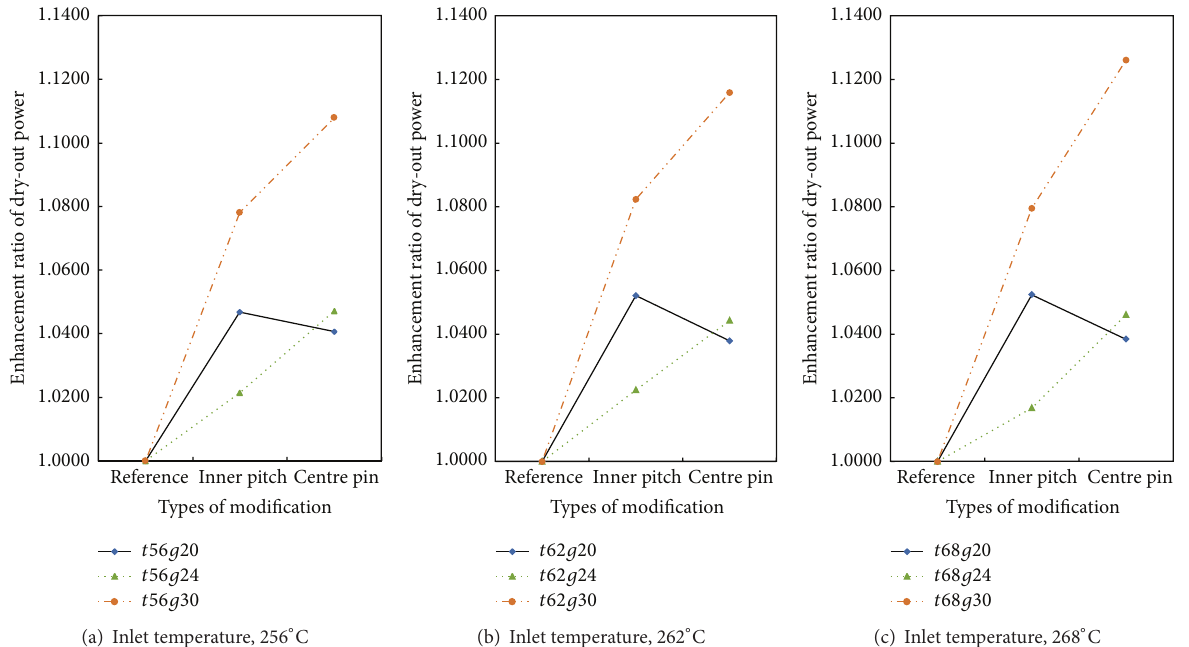
Figure 12: Comparison of dry-out enhancements of inner pitch and center element modificationsin terms of a 37S fuel bundle.